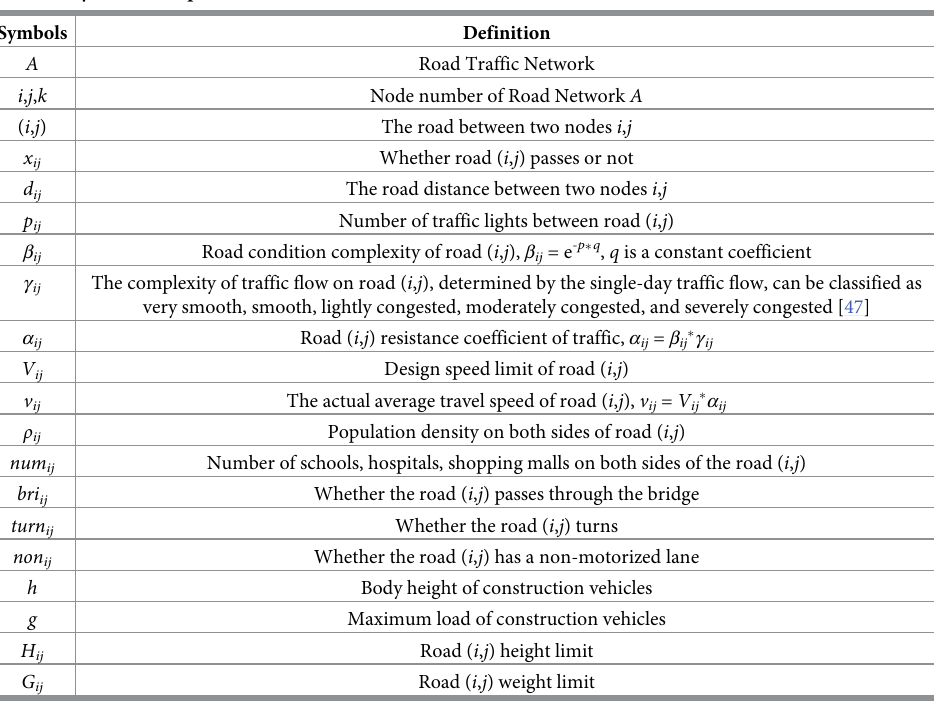
Table 2. Symbol description. Symbols